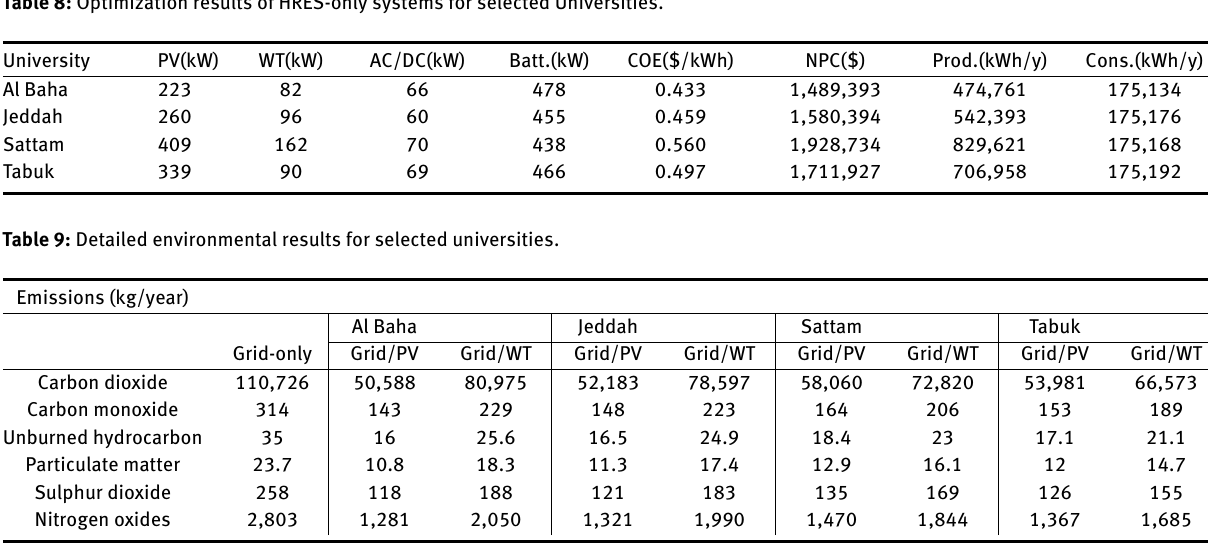
Table 8: Optimization results of HRES-only systems for selected Universities.